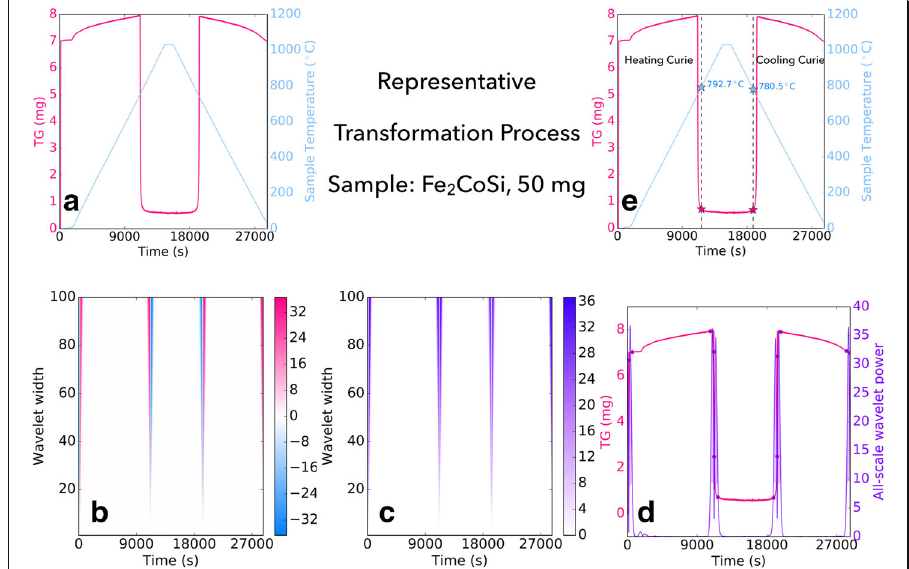
Fig. 4 End to end process of wavelet transform method for Curie point detection. a : Tg (mg) signal vs time (seconds) and sample temperature profile (°C) from Setsys 15/18. b : CWT (arbitrary units) of Tg (mg) signal vs time (seconds) c : Wavelet power spectrum (same arbitrary units as b ) d : Total wavelet power as a function of time, with regions of increased relative excitation shaded, and Tg (mg) signal marked with critical points e : Curie transition points identified from the set of critical points and marked on the Tg (mg) and sample temperature (°C)